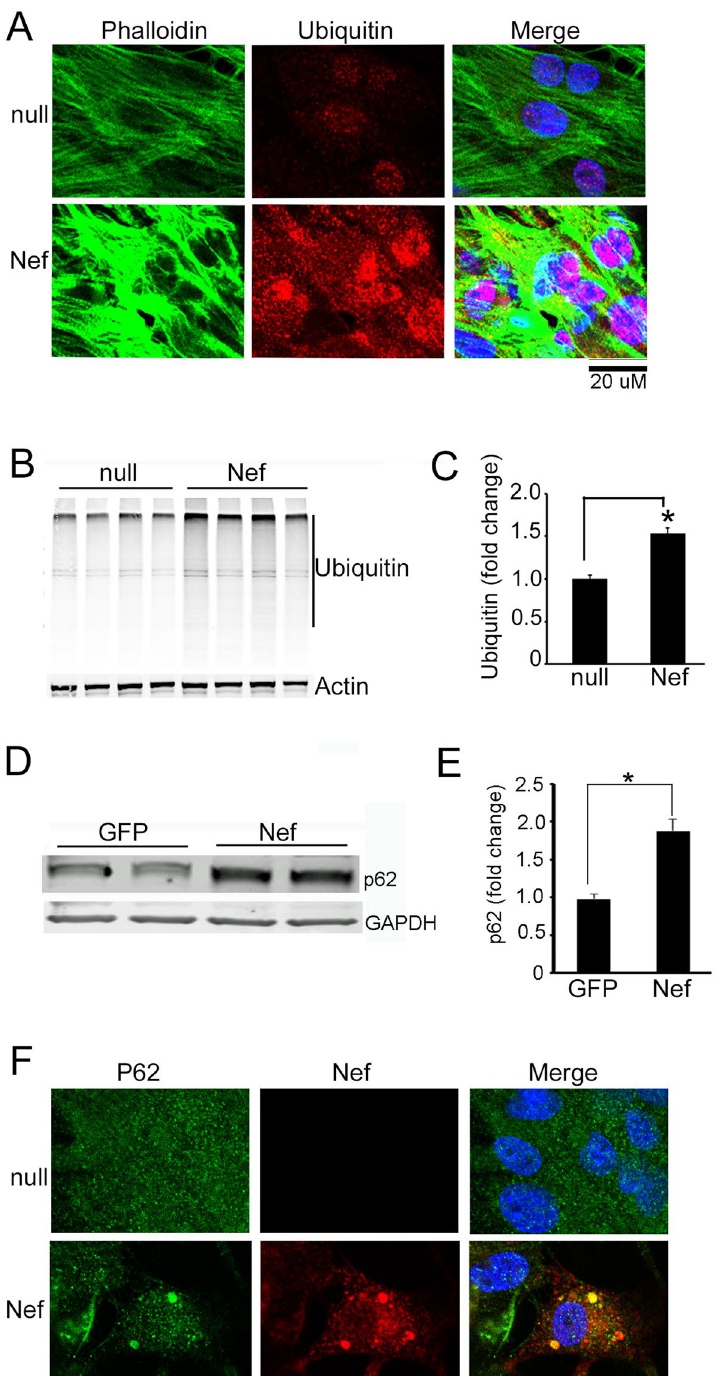
Figure 4. Nef increased accumulation of protein aggregates in cardiomyocytes. ( A ) Representative confocal images show accumulation of ubiquitin in the cardiomyocytes expressing Nef. NRVCs were transduced with control Ad-null or Ad-Nef for 48 hours, fixed with 4% PFA, and stained with ubiquitin antibody. ( B , C ) Western blot analysis confirms that ubiquitin levels are increased in the Nef-treated cardiomyocytes (n = 4g/group, * P < 0.05, significant difference between Ad-null and Ad-Nef). ( D , E ) NRVCs were transduced with Ad-Nef or Ad-GFP for 48 hours and total protein lysates were analyzed by Western blot using SQSTM1/p62-specific antibody; p62 levels are significantly increased in Nef-expressing cardiomyocytes (n = 6/group, * P < 0.05, significant difference between Ad-GFP and Ad-Nef). ( F ) Representative confocal images indicate that Nef and p62 are colocalized in perinuclear aggregates in Nef-expressing cells. NRVCs were transduced with Ad-null or Ad-Nef for 48 hours and cells fixed with 4% PFA and stained with Nef- and p62-specific